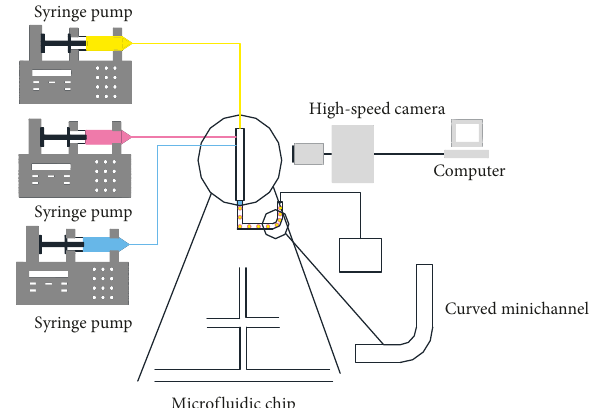
Figure 3: Schematic of the validation experiment